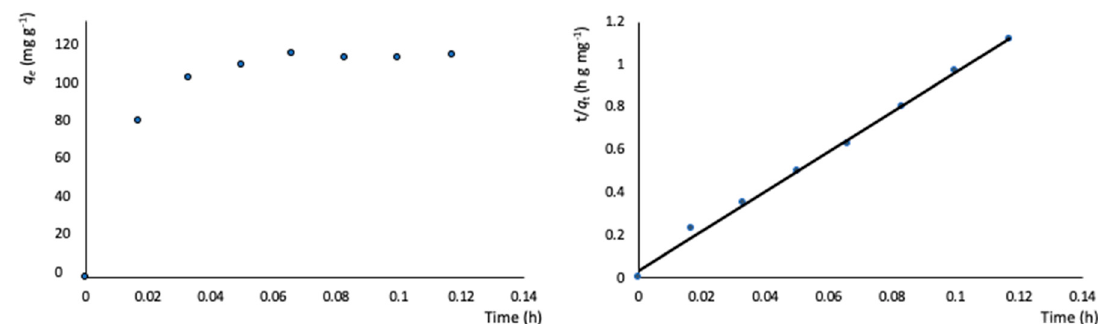
Figure 8. Left: metal adsorption capacity (mg g − 1 ) versus time (h) plot; right: simulation of the experimental data to the pseudo-second order kinetic model. The solid lines represent the fitting of the data.